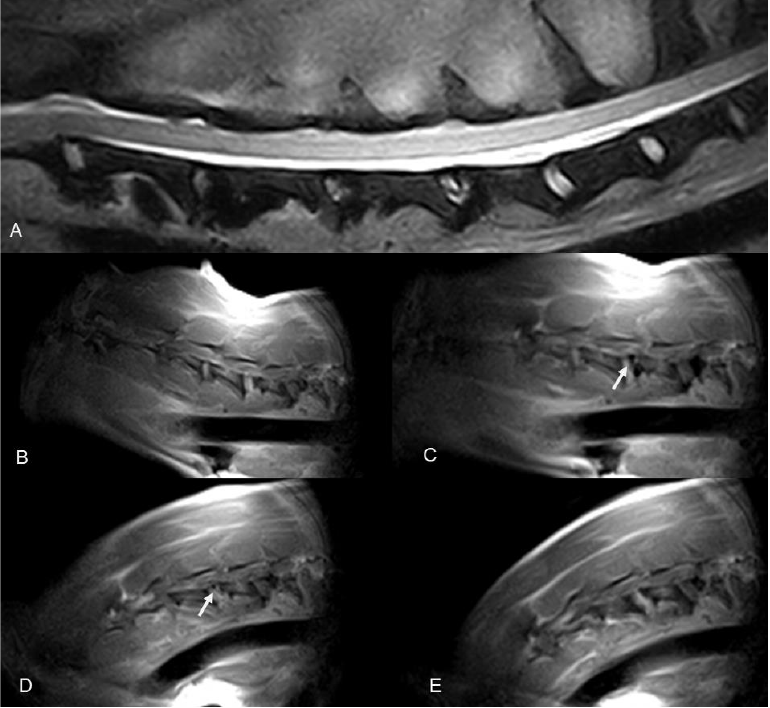
Figure 3. Dobermann, 8 years old, male entire (Case 7). Cervical spine MRI sample images: ( A ) T2 weighted mid-sagittal image of the cervical spine. ( B – E ) Real-time kMRI during neck flexion, C4 – C5 mild dynamic subluxation is visible (arrows).